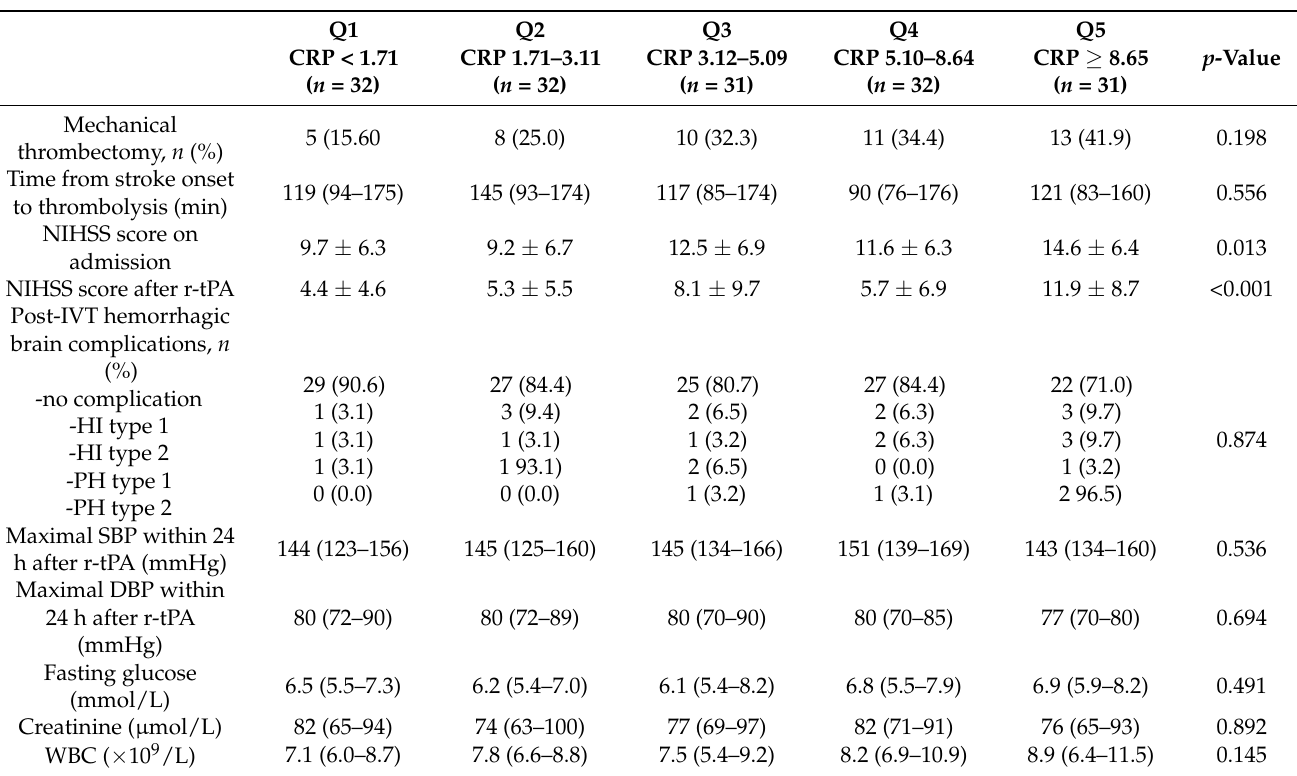
(Supplemental Table S1). There was no correlation between CRP and fasting glucose levels (r = 0.11, p =